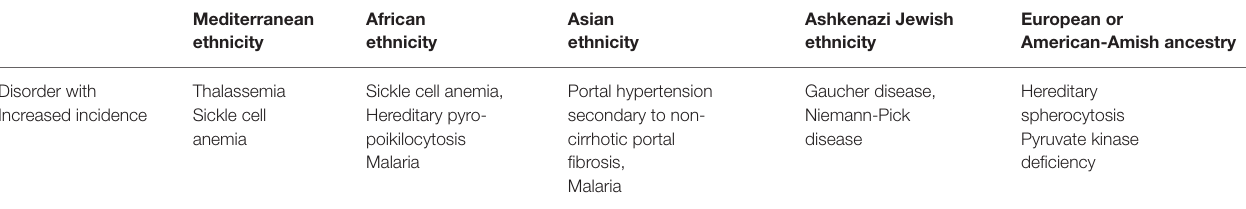
TABLE 1 | Causes of splenomegaly to be considered in individuals with different ethnicities due to interfering genetic or infectious factors